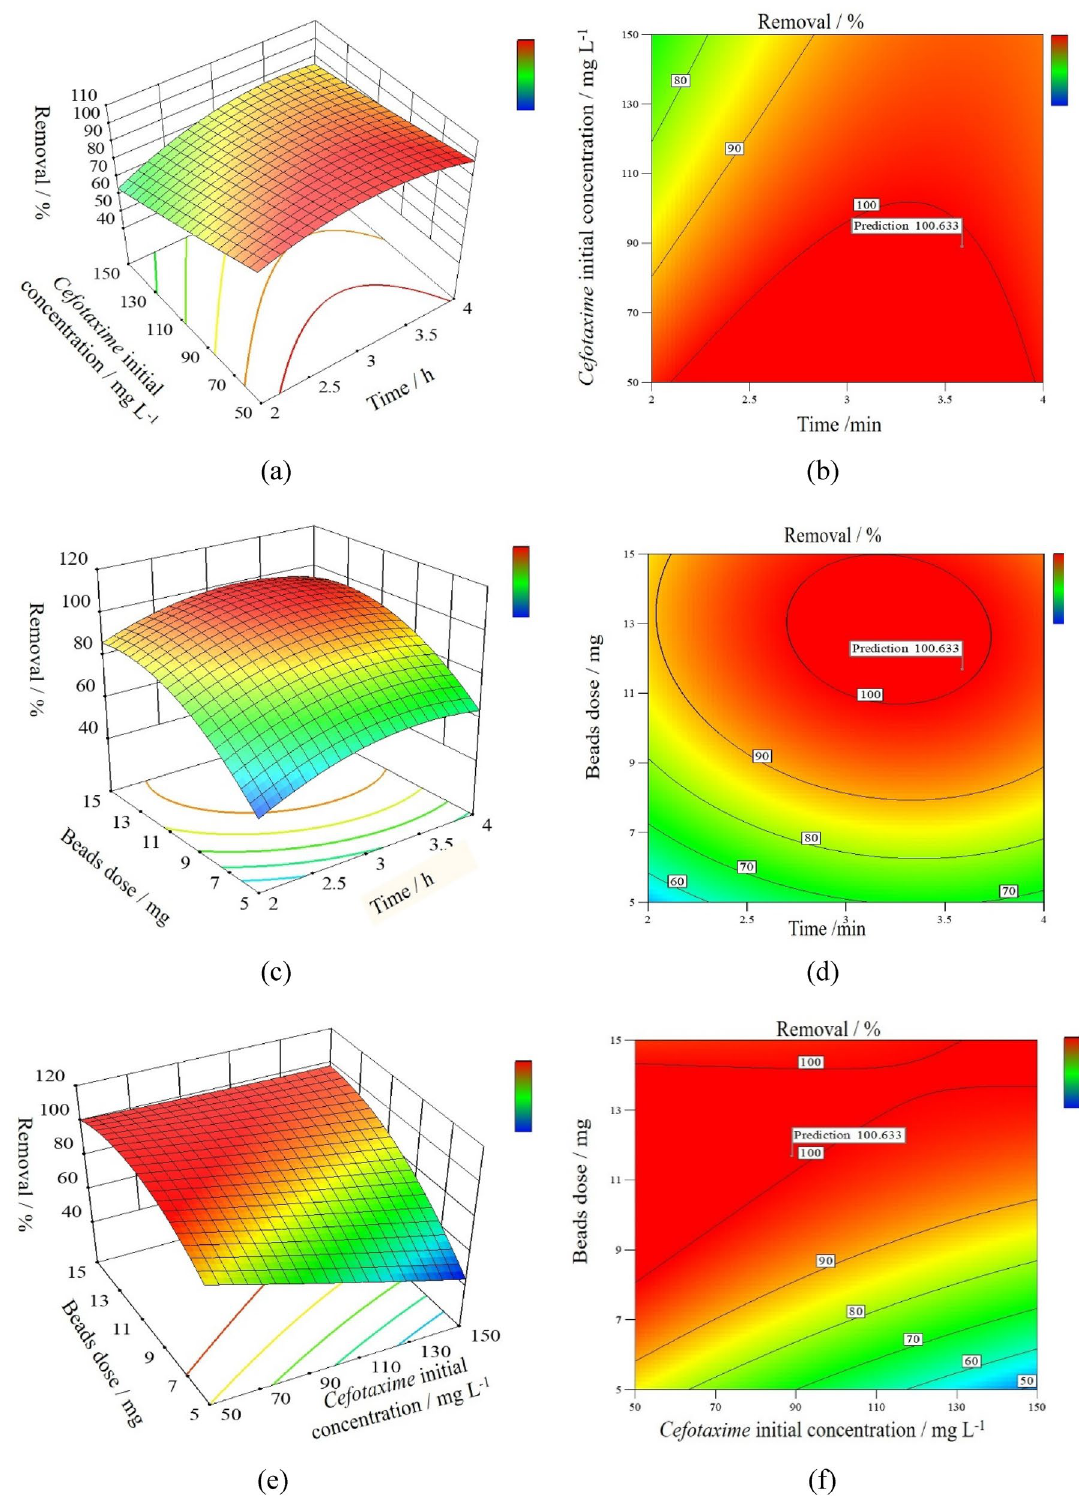
Figure 7. Response surface plots for removal efficiency (%) of Cefotaxime onto SPVA/IC/SZrO 2 -2.5 nanocomposite beads ( a,c,e ) 3D surface plots and ( b,d,f ) 2D surface